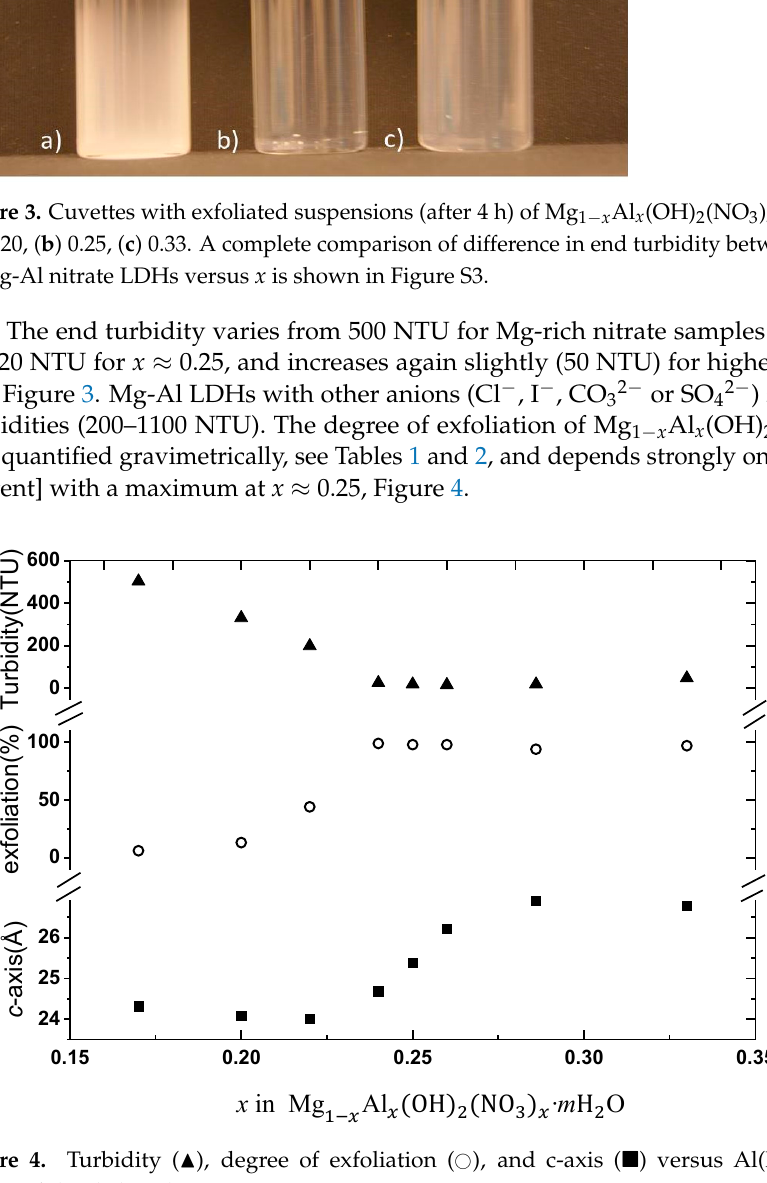
), and c-axis ( (cid:4) ) versus Al(III) content x in (cid:35)